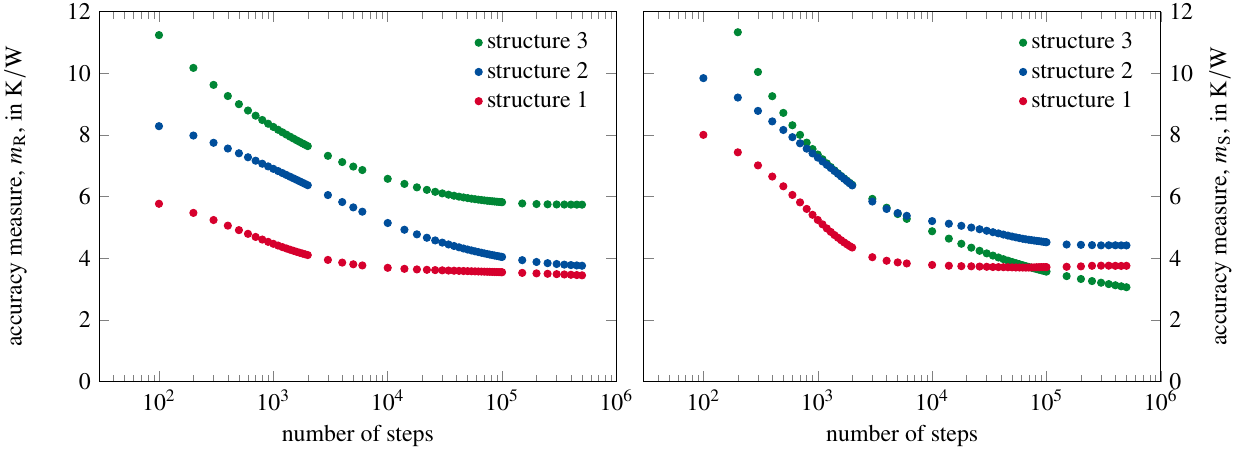
Figure 4. Accuracy of the time constant spectrum, m R , and structure function, m S , as a function of number of steps for Bayesian deconvolution. The number of points is set to N g =